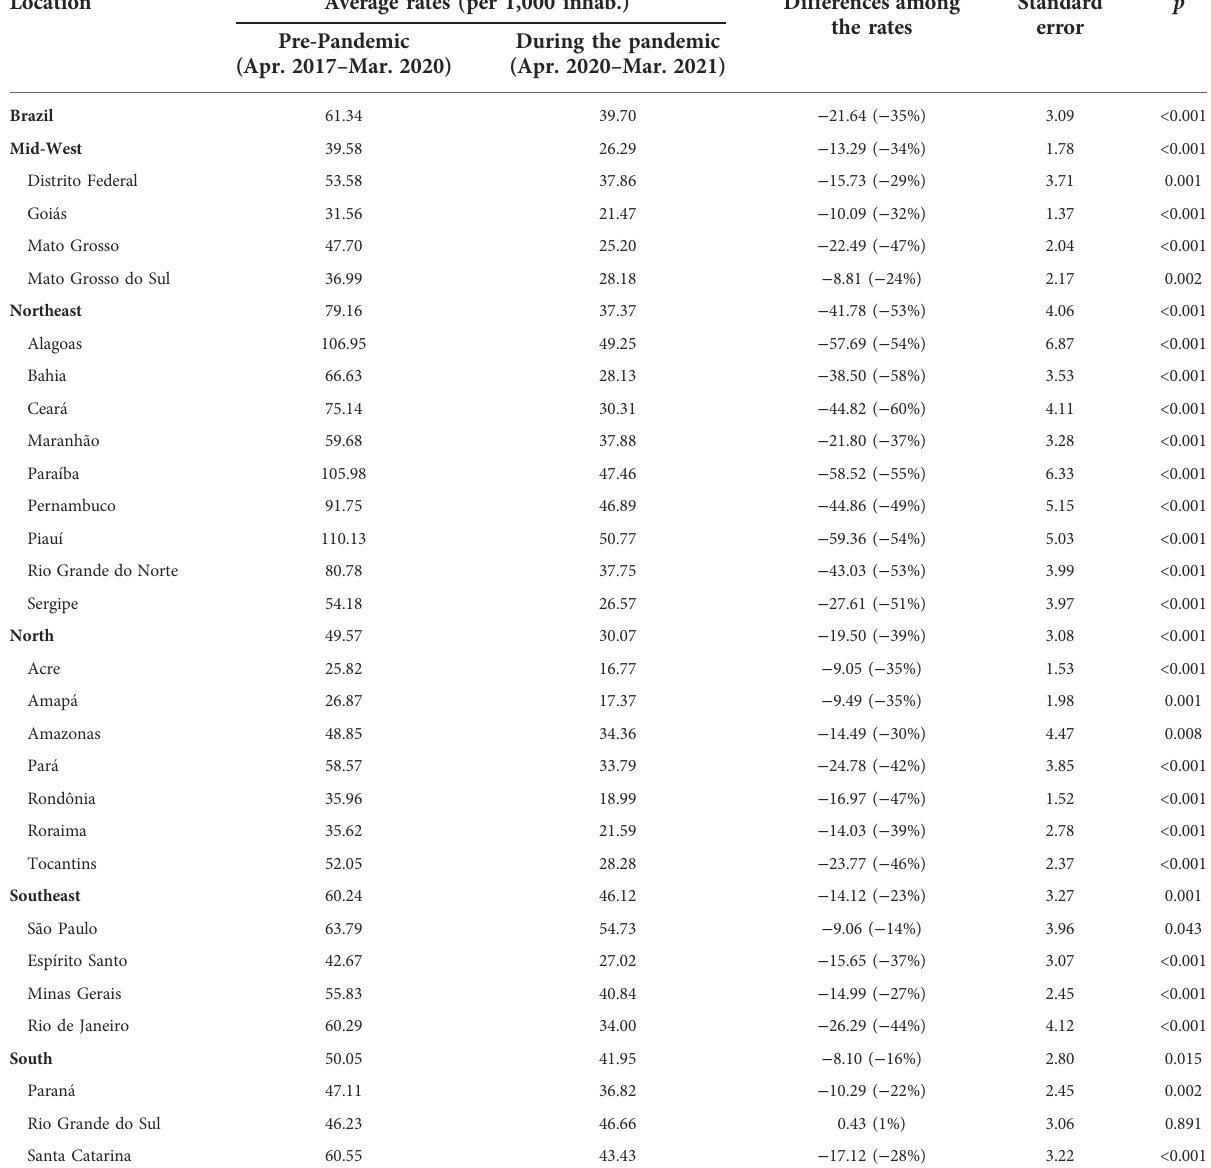
TABLE 2 Differences among the average rates of visits before and during the pandemic, according to regions, states, and the Federal District. Location Average rates (per 1,000 inhab.)